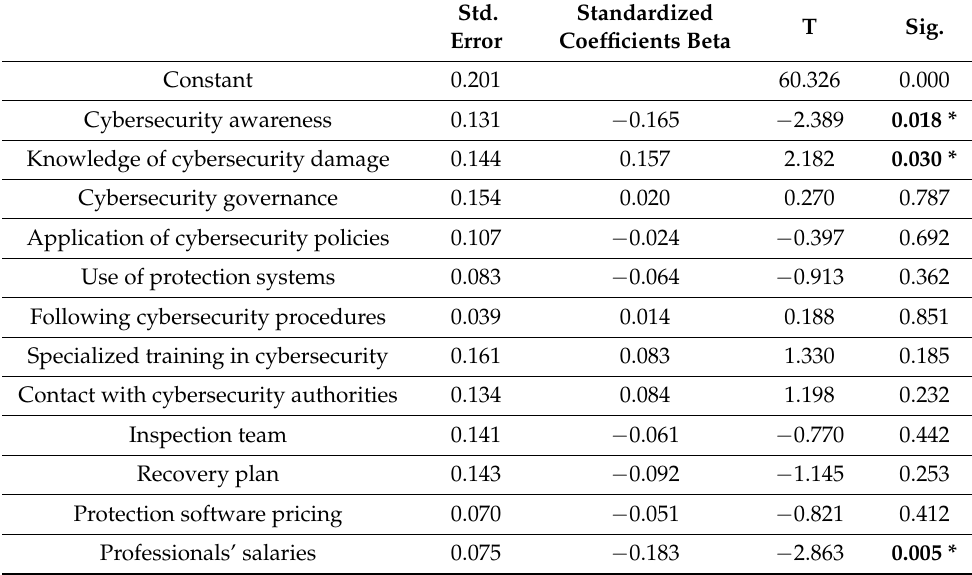
Table 7. Model coefficients (loss of sensitive data).